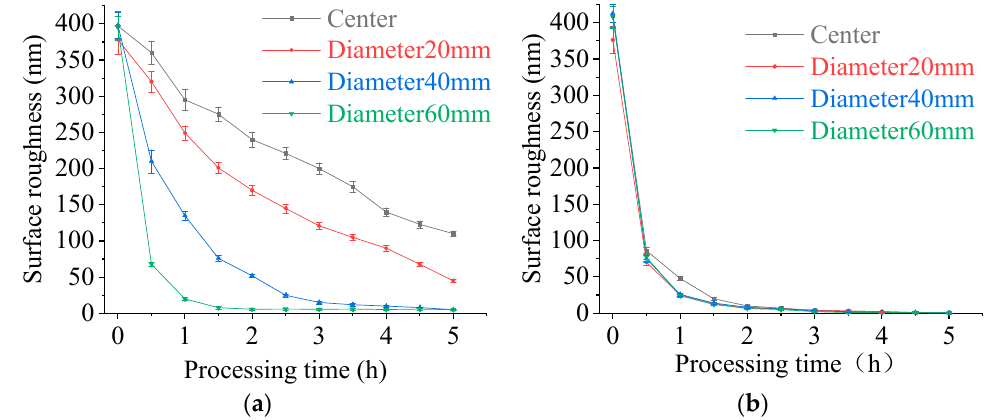
Figure 6. Variation of surface roughness at different diameters of silicon wafer: ( a ) traditional CMP; ( b ) DEPP.